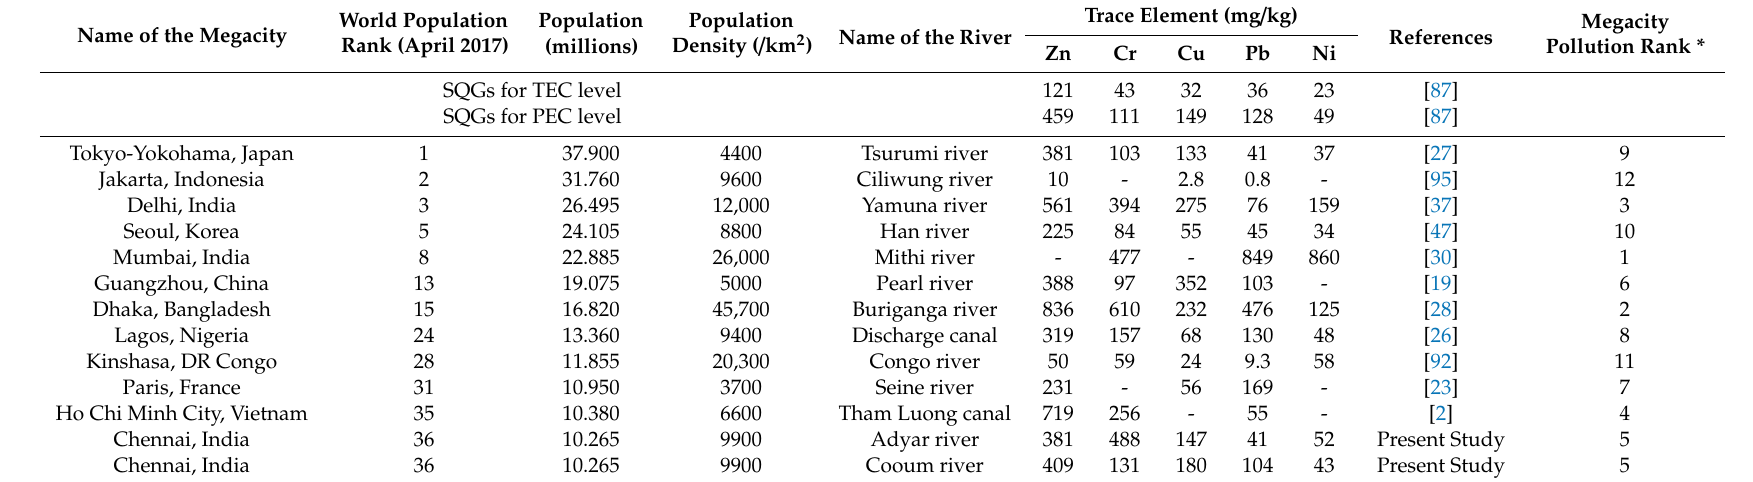
Table 4. Mean concentrations of trace elements in surface sediments of various megacity rivers and canals and their associated megacity pollution ranking based on sediment quality guidelines